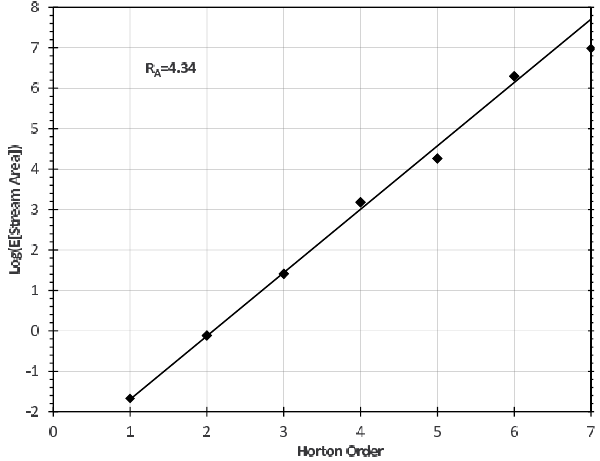
Figure 7. Reproduction of the original figure of Mantilla and Gupta (2005, Fig. 2) showing the scaling of mean drainage area with order (Horton law) of the river network of the Whitewater basin, Kansas, US.